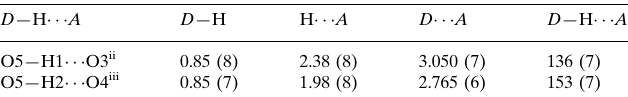
Hydrogen-bond geometry (A˚ , (cid:2)